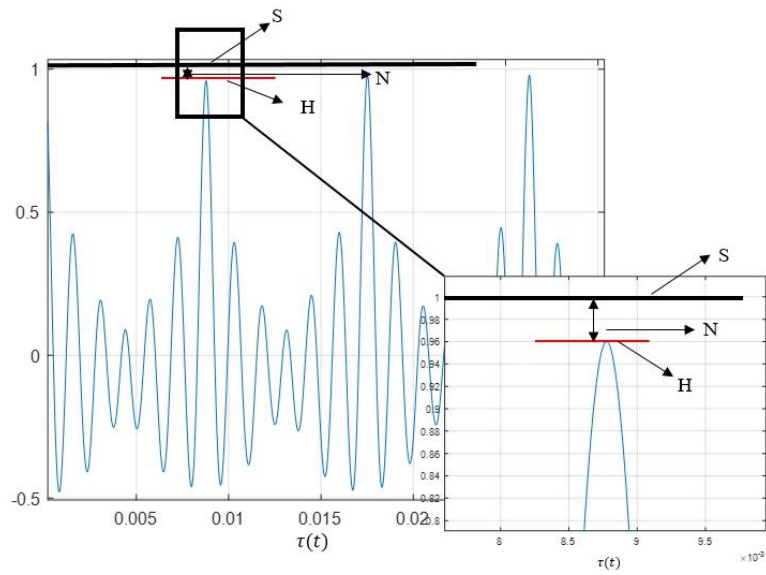
Figure 2. Determination of NHR from the normalized Autocorrelation.